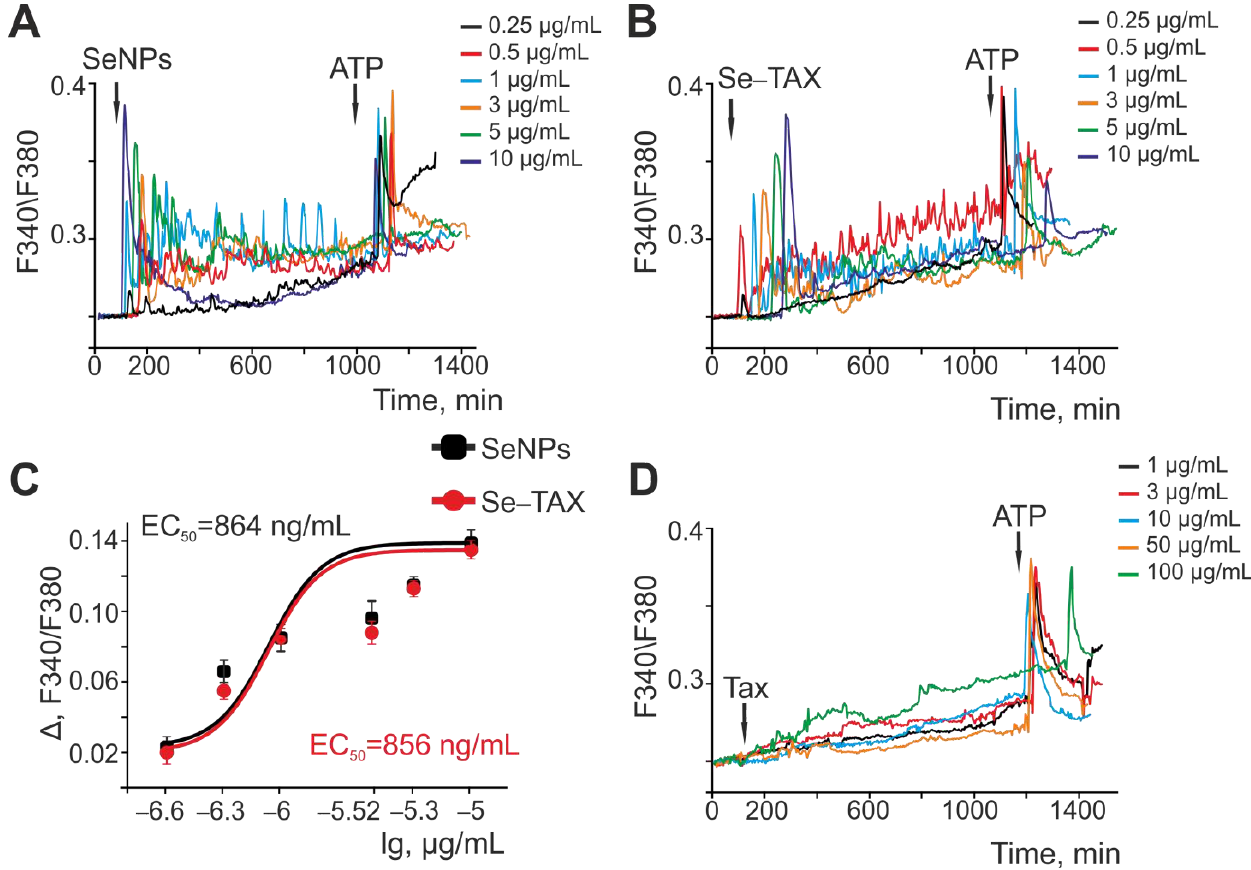
Figure 4. Activation of the Ca 2+ signaling system of cortical astrocytes by different concentrations of SeNPs ( A ) and Se – TAX ( B ). ( A , B ) Application of various concentrations of SeNPs ( A ) and Se – TAX ( B ) induces the generation of Ca 2+ signals in the cortical astrocytes. Ca 2+ signals in astrocytes averaged over several dozens of cells in one experiment are presented. ( C ) Dependence of the amplitude of Ca 2+ responses of astrocytes on the growth concentration of SeNPs (black squares) and Se – TAX (red circles) and its approximation by a sigmoid function. ( D ) Application of various concentrations of taxifolin (TAX) does not cause the generation of Ca 2+ signals by astrocytes of the cerebral cortex.